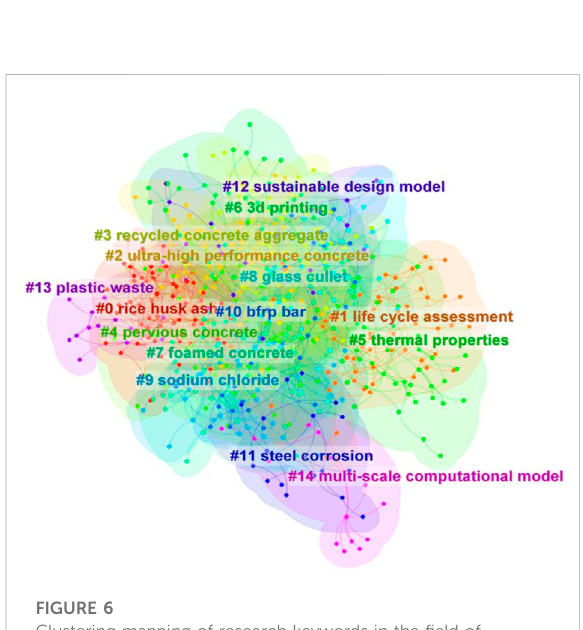
FIGURE 6 Clustering mapping of research keywords in the fi eld of ecological concrete